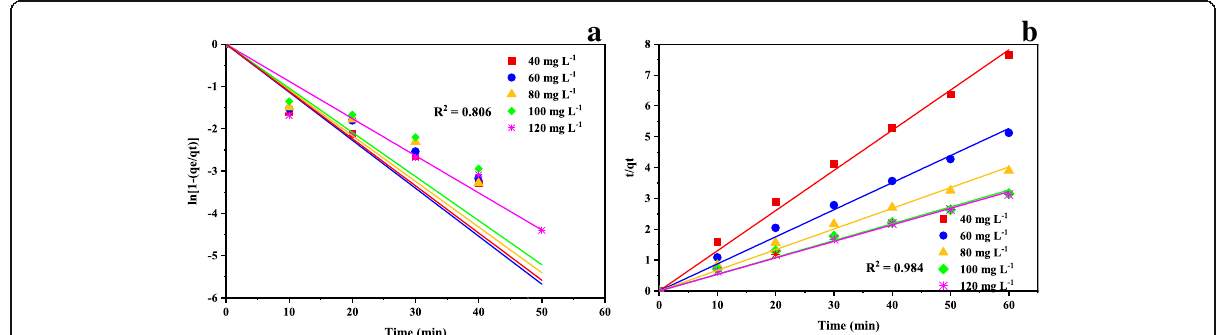
Fig. 6 Kinetic models for ( a ) pseudo first order for RB-21 on adsorbent for different initial concentration, and ( b ) pseudo second order for RB-21 on adsorbent for different initial concentration. (Initial concentration-40, 60, 80, 100, 120 mg L − 1 , Adsorbent doage-0.25g, Contact time-60 min, Agitation rate-200 rpm, Volume-50mL)